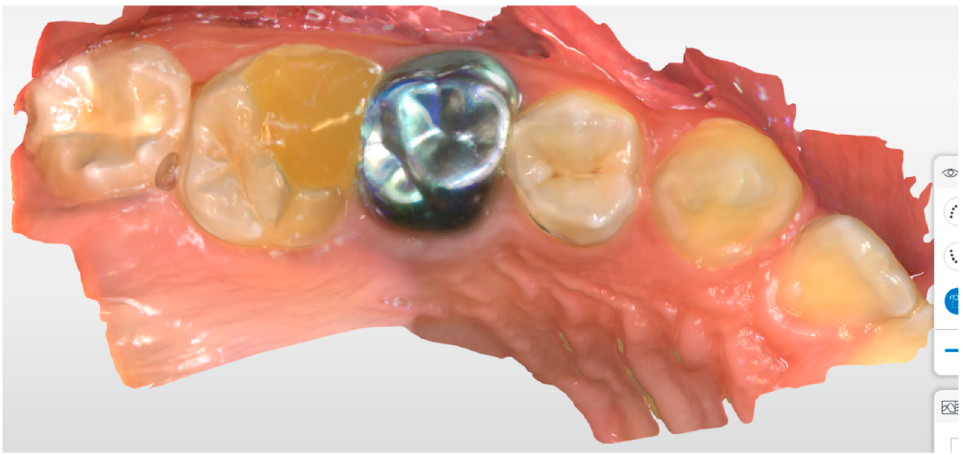
Figure 3. A scan of tooth #16 before tooth preparation.